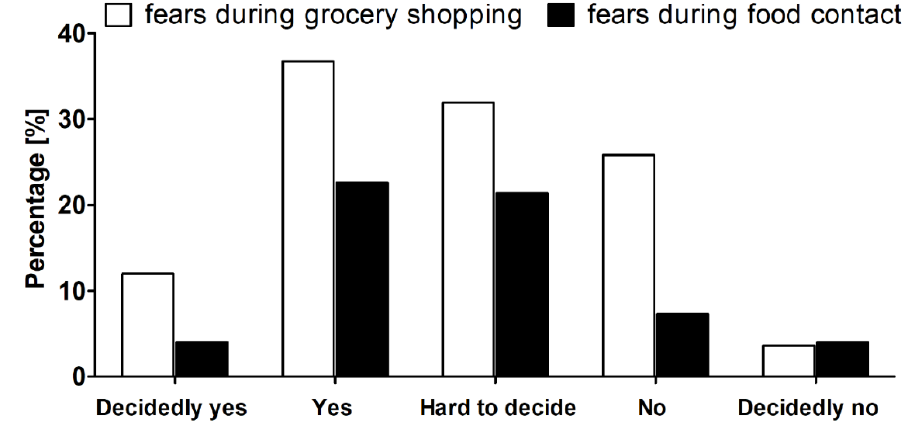
Figure 2. Reported fears over contracting SARS-CoV-2 during shopping for food and contact with in the surveyed group ( n = food in the surveyed group ( n = 1097).